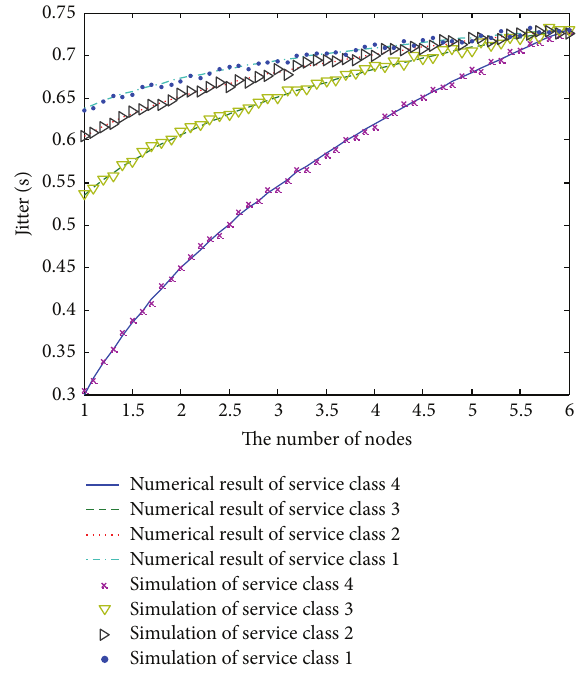
Figure 3: Jitter performance according to service